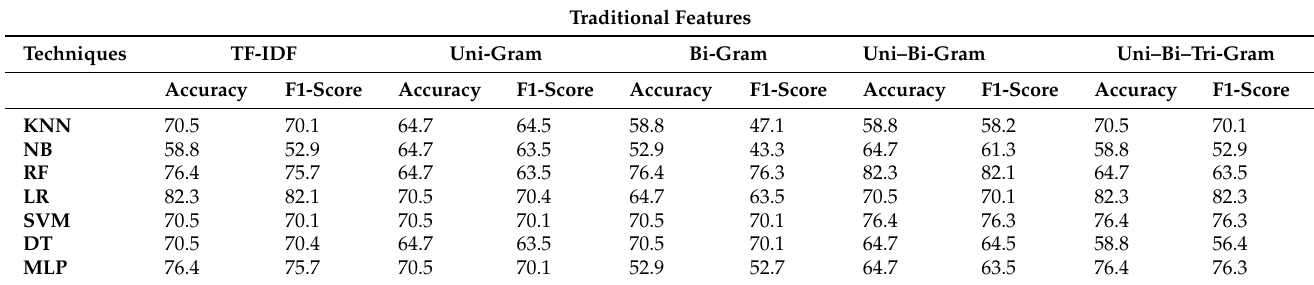
Table 9. Real-time tweets dataset result for ML classifiers with modified labeling.